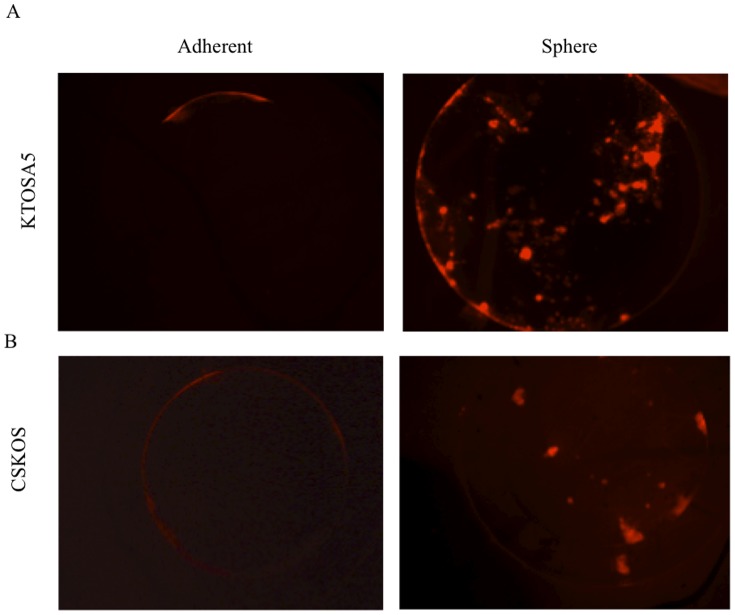
Osteosarcoma spheres are enriched for higher tumourigenicity in vivo.Disassociated spheres and adherent, of KTOSA5 cells (A) and CSKOS cells (B), were inoculated directly onto the chorioallantoic membrane of a chicken embryo at day 7 of development. All cells were fluorescently labelled and imaged 5 days after inoculation.